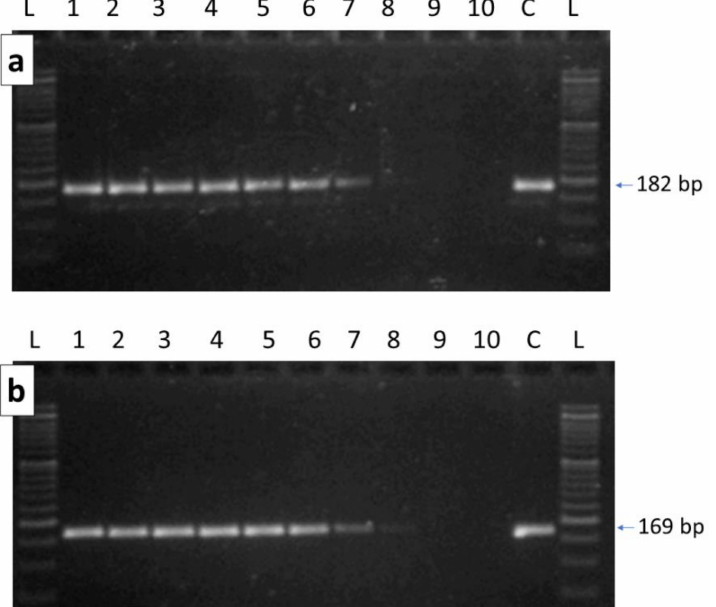
Figure 2. Gel electrophoresis analyses of the amplified fragments of the G. mellonella COI gene regions (( a ) 182 bp obtained from GallMelCox1_182 primer pair; ( b ) 168 bp obtained from GallMelCox1_168 primer pair) obtained at different concentrations of the targeted template DNA. L = DNA